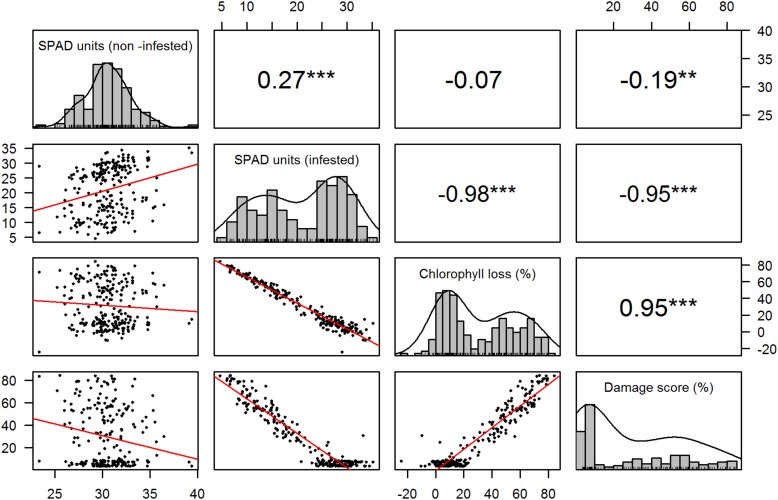
Trait distribution and correlation. The diagonal displays the histogram for each recorded trait. The panels below and above the diagonal represent the scatter plots and correlation values between traits, respectively. ∗∗p = 0.01, ∗∗∗p < 0.001.